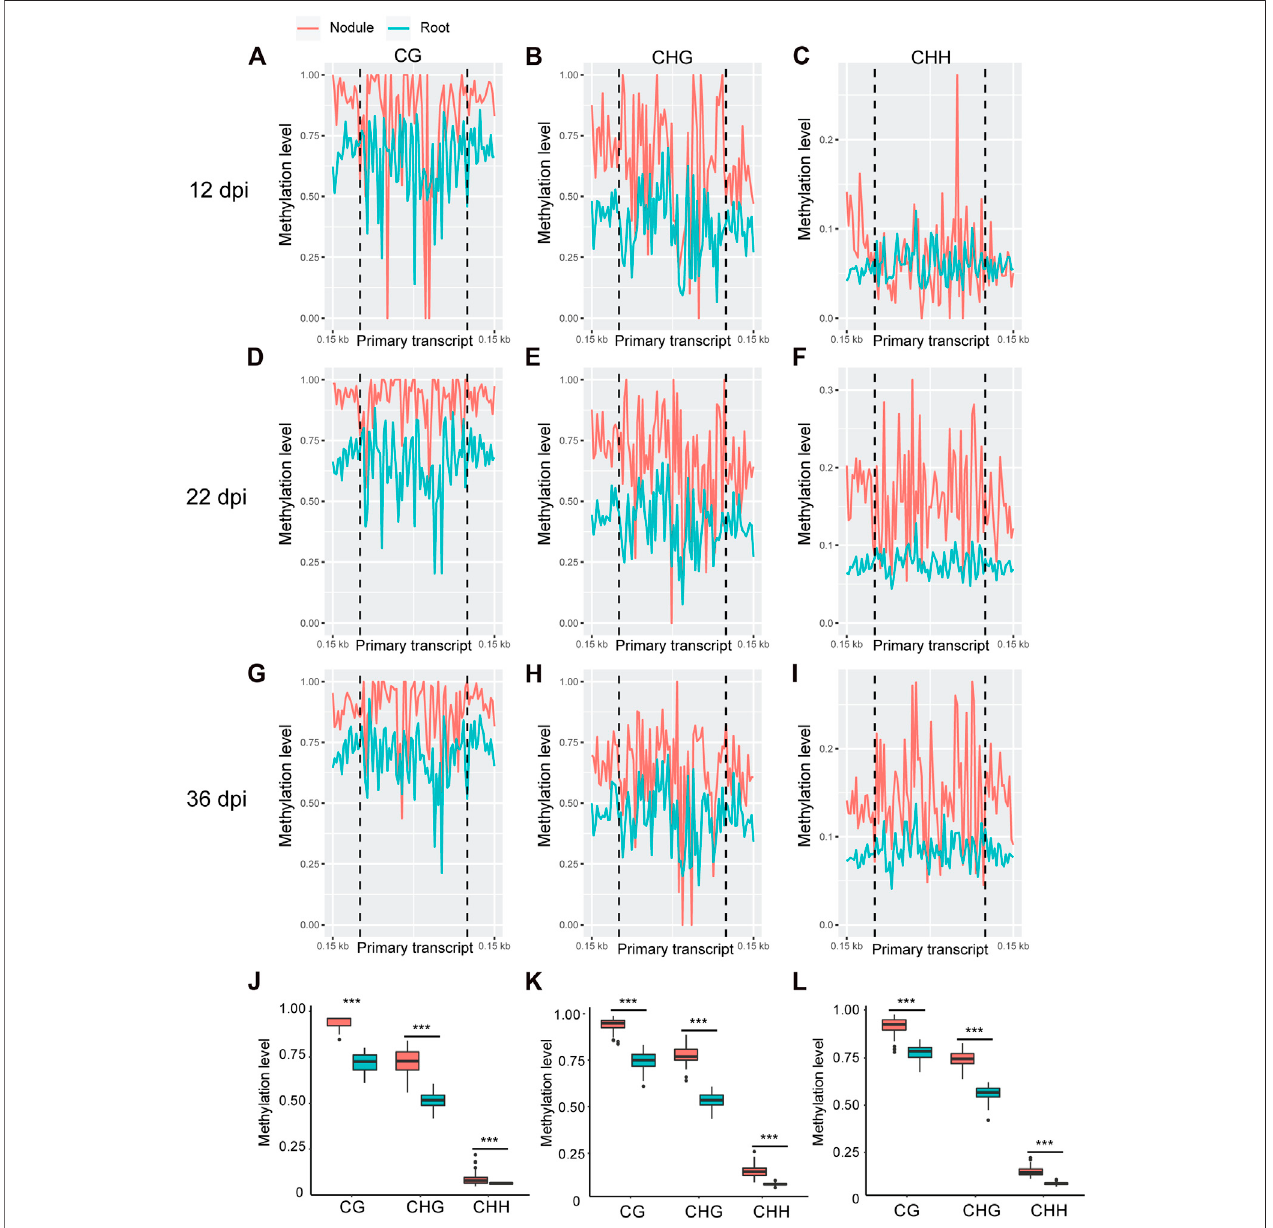
FIGURE 2 | Absolute DNA methylation levels across miRNA primary transcript region in soybean nodules and roots at 12, 22, and 36 dpi. (A – I) : Differences in globalDNA methylation levels between nodules and roots over miRNA primary transcript region in the CG, CHG, and CHH sequence contexts at 12 – (A – C) , 22 – (D – F) , and 36 – dpi (G – I) . The vertical dotted fl ank the miRNA primary transcript region, and 0.15 kb indicates the distance from the middle of primary transcript region. (J – L) : Boxplots demonstrating statistically signi fi cant differences in absolute methylation levels across miRNA primary transcript region between nodules and roots in various sequence contexts at 12 (J) , 22 (K) , and 36 dpi (L) . Asterisks indicate p < 0.001 for the comparison between nodules and roots as determined by t